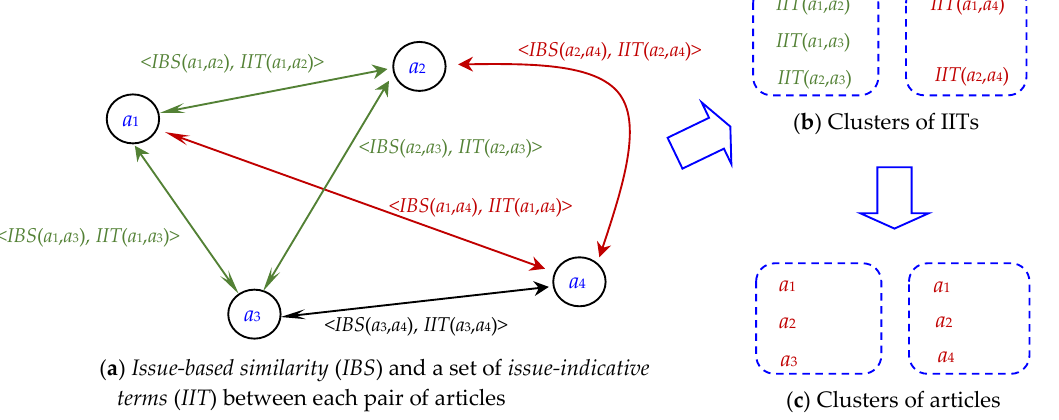
Figure 2. Main steps of ICRT: ( a ) estimating IBS and identifying IIT between each pair of articles; ( b ) clustering the IITs, and ( c ) producing clusters of articles accordingly.